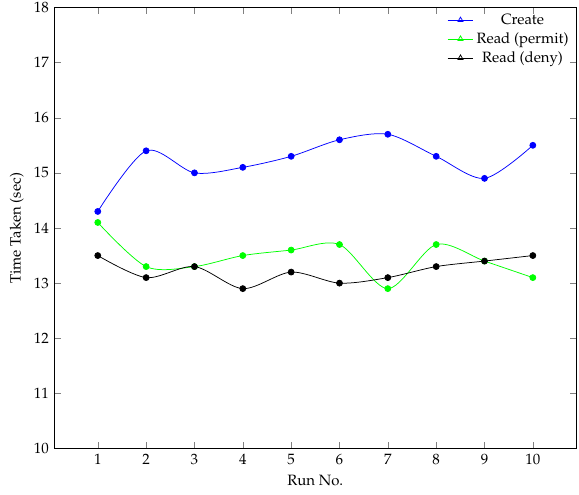
Figure 8. Time taken to Create and Read. Table 1. Average time (s) taken to Create, Read, and